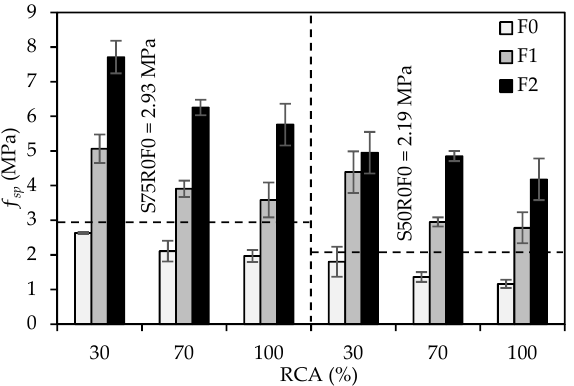
Figure 15. Splitting tensile strength of 28-day alkali-activated slag concrete.